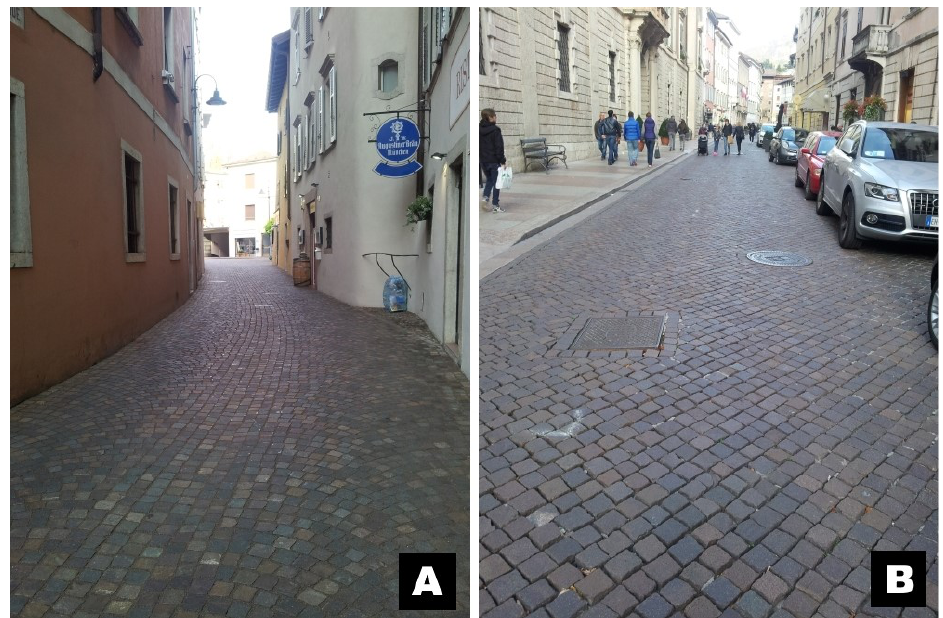
Figure 1 Photographs of streets without ( A ) and with ( B ) pavements in the historic centre of